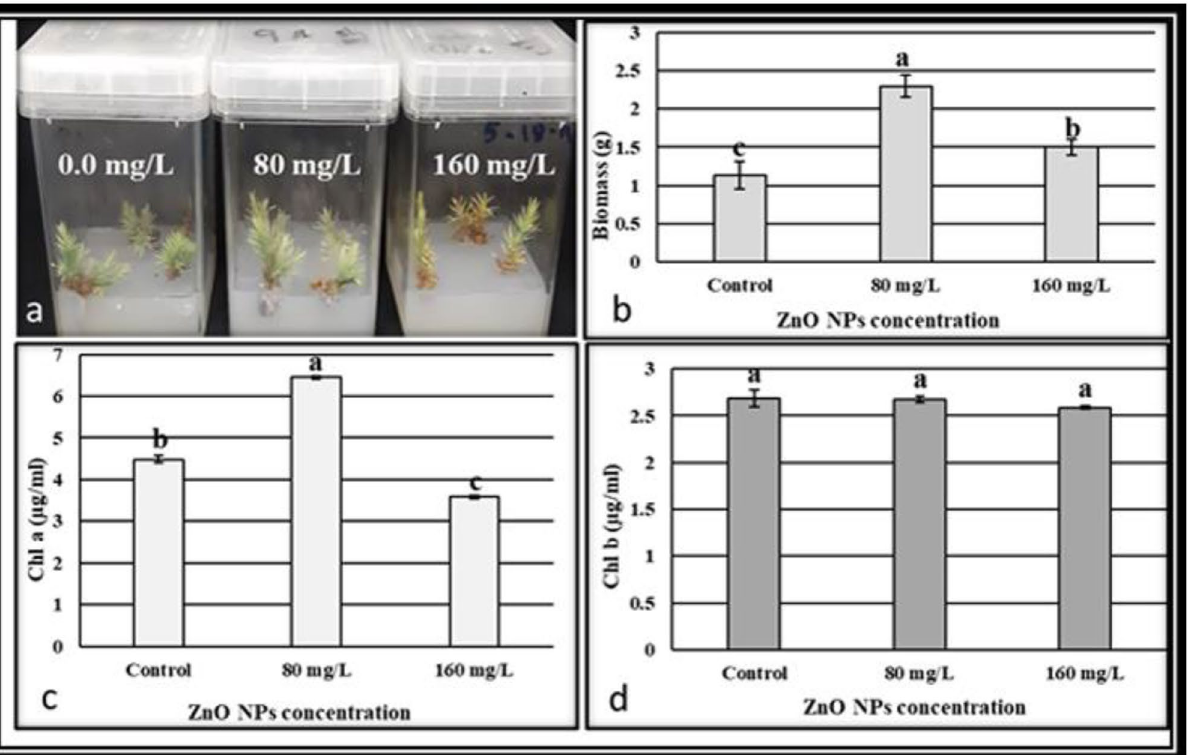
Figure 2. ( a ) Plants growth under different treatments of biosynthesized ZnO NPs ( b ) Biomass of plants under different treatments of biosynthesized ZnO NPs (g) ( c ) Chl a under different treatments of biosynthesized ZnO NPs (mg/ml) and ( d ) Chl b under different treatments of biosynthesized ZnO NPs (mg/ml). The data are presented the average of parameters ± SD. a,b,c Means within the same column with different superscripts differ significantly ( P <